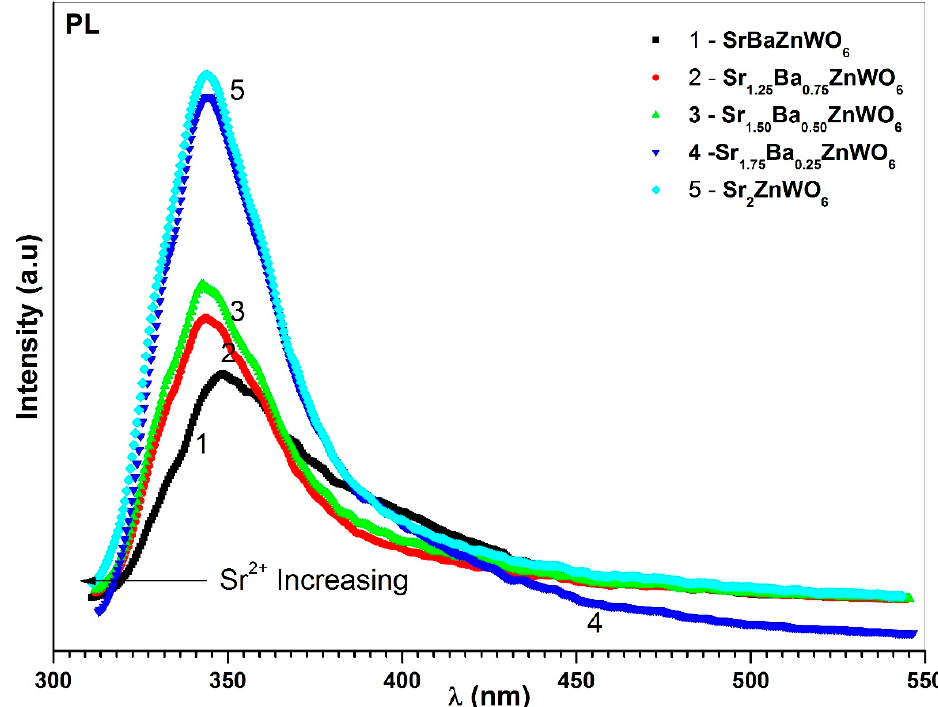
Figure 12. PL of the Ba 2 − x Sr x ZnWO 6 (x = 1, 1.25, 1.50, 1.75, 2) double perovskite series.